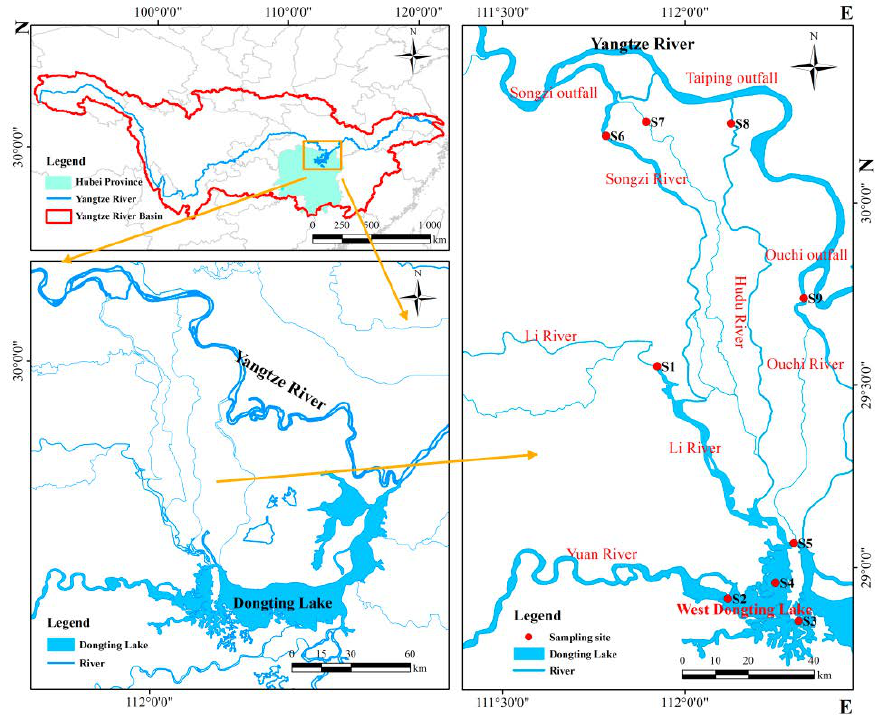
Figure 1. Map of the study area and water sampling site. Table 1. Basic information on sampling sites located in West Dongting Lake and its inflow rivers. Basic Information